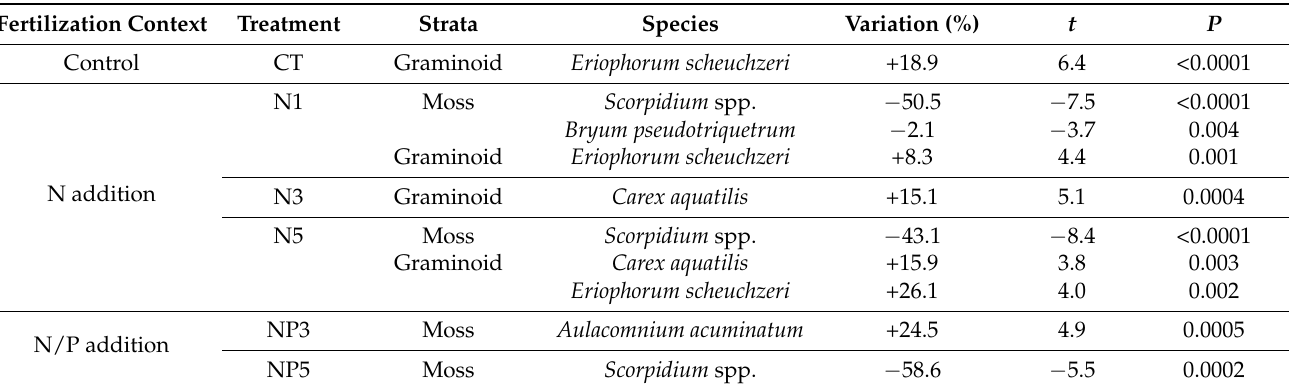
Table 3. Variation in plant species cover by vegetation strata for each fertilization treatment between year 2 and year 17 of the experiment in the tundra wetlands of Bylot Island, Nunavut). Only species with significant changes after a sequential Bonferroni correction are presented (paired t test, P < 0.00385, df = 11).